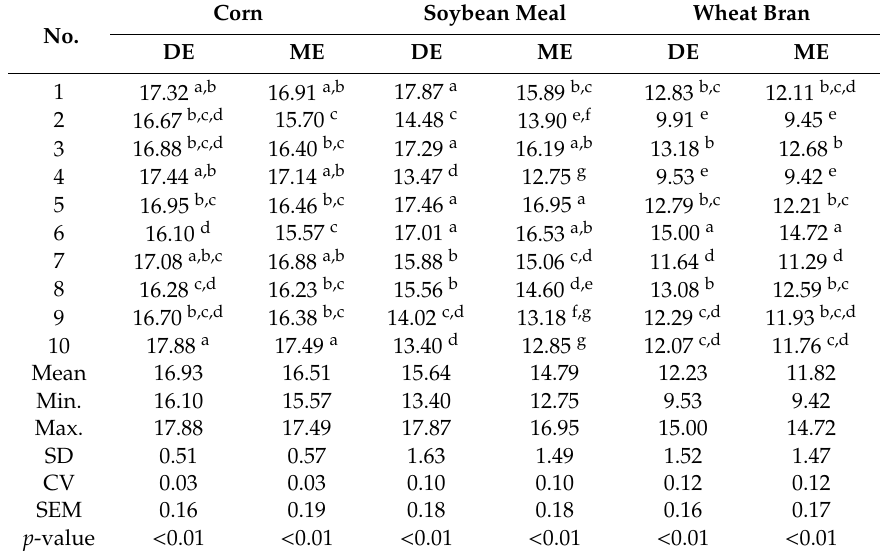
Table 6. Energy values for corn, soybean meal and wheat bran (MJ / kg, Dry matter basis) 1